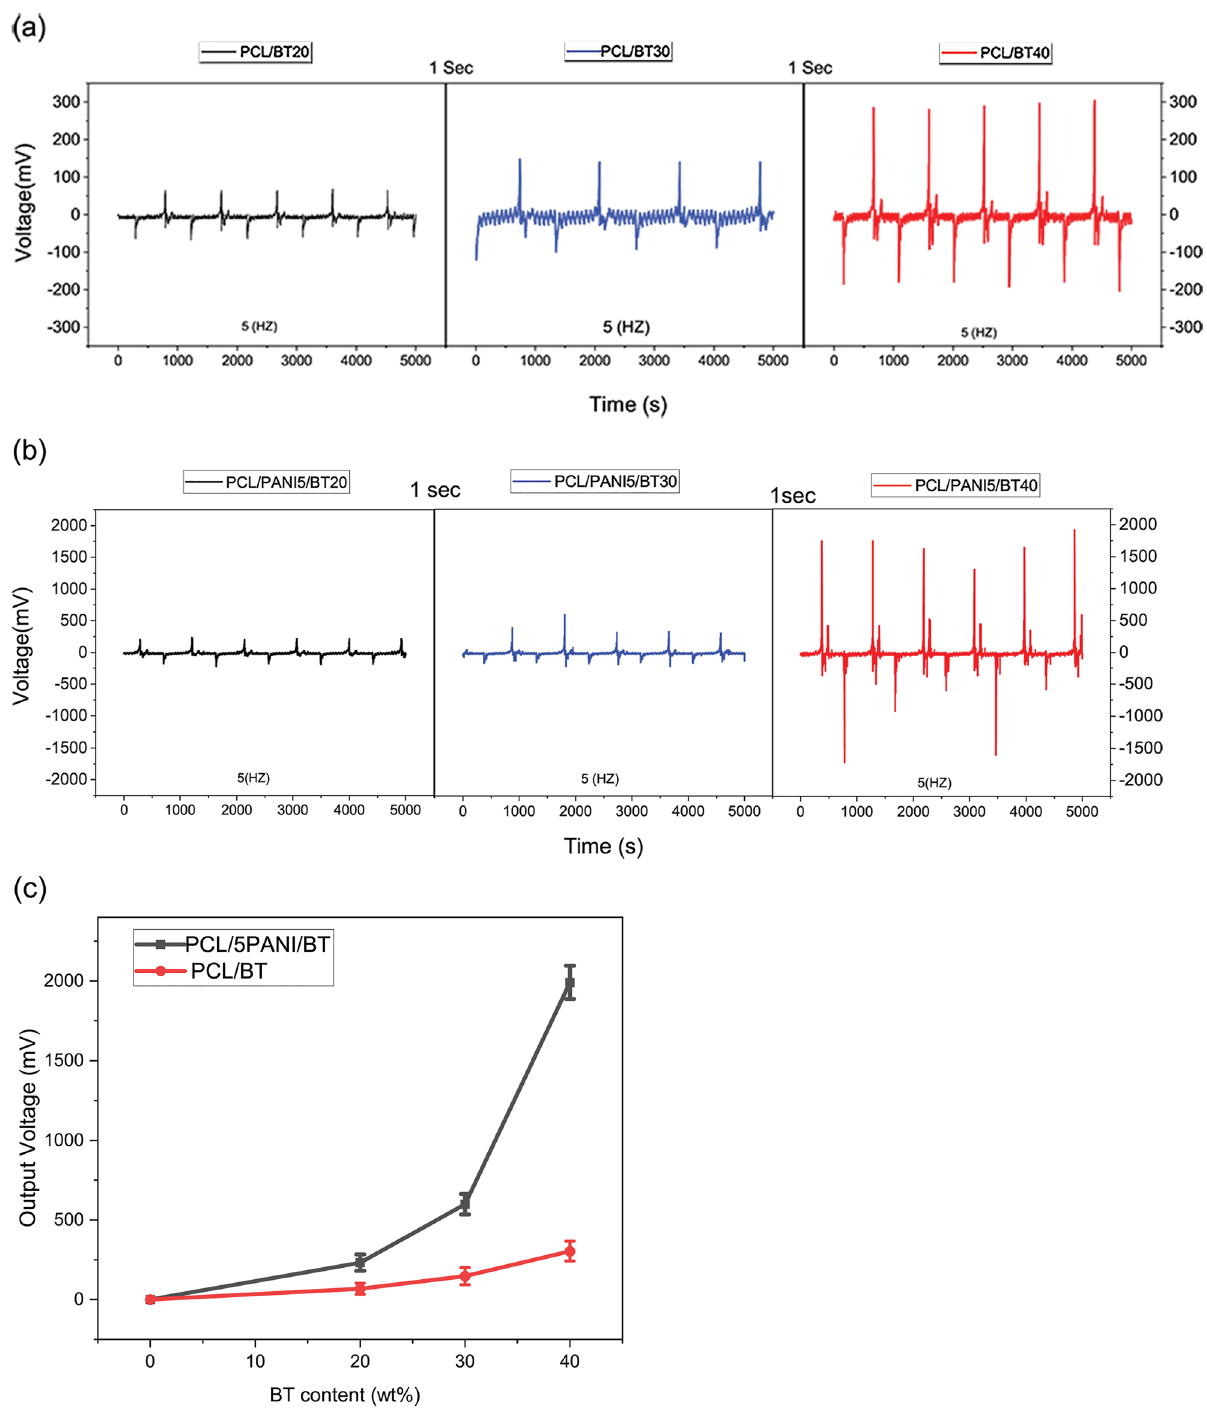
Figure 6. The recorded piezo-voltage of nanocomposite fibers. ( a ) BT content scaffolds; PCL/BT20, PCL/ BT30, and PCL/BT40, ( b ) BT and PANI content scaffolds; PCL/PANI5/BT20, PCL/PANI5/BT30 and PCL/ PANI5/BT40 ( c ) output voltage of PCL/BT versus PCL/PANI5/BT (20, 30, and 40 wt.% BT), comparison of piezo-voltage of containing PANI and non-containing PANI scaffolds. PANI NPs had a synergic effect on piezoelectricity and enhanced the output voltage of nanocomposites. Conductive PANI NPs assisted to decrease the internal resistance of ternary nanocomposite by introducing conductive